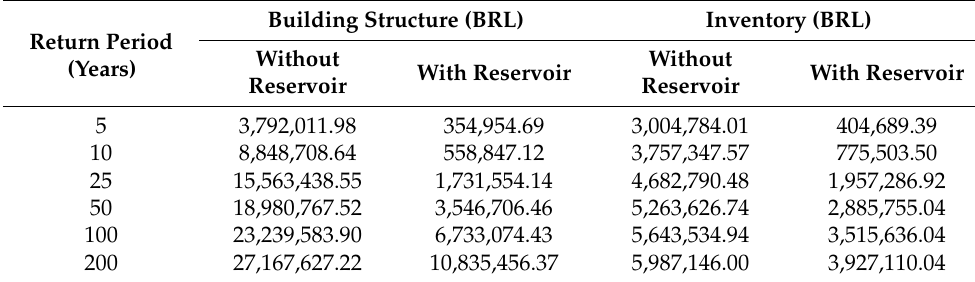
Figure 7. Steps to calculate the risk curve: ( a ) depth x flow ( b ) depth x damage ( c ) probability x flow ( d ) probability x damage. Table 5. Damage estimation in Palmares-values for January